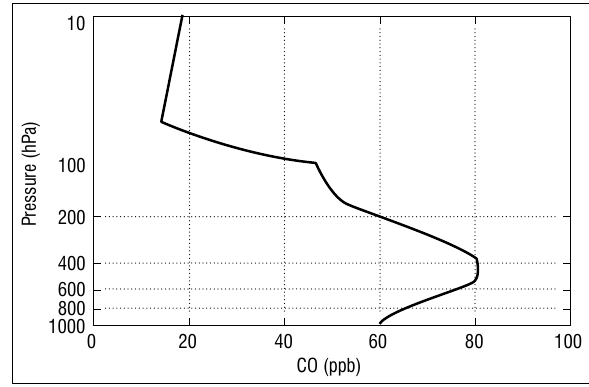
Figure 3: Height profile of CO measured by a tropospheric emission spectrometer overpass over Cape Point in South Africa on 03 January 2007.